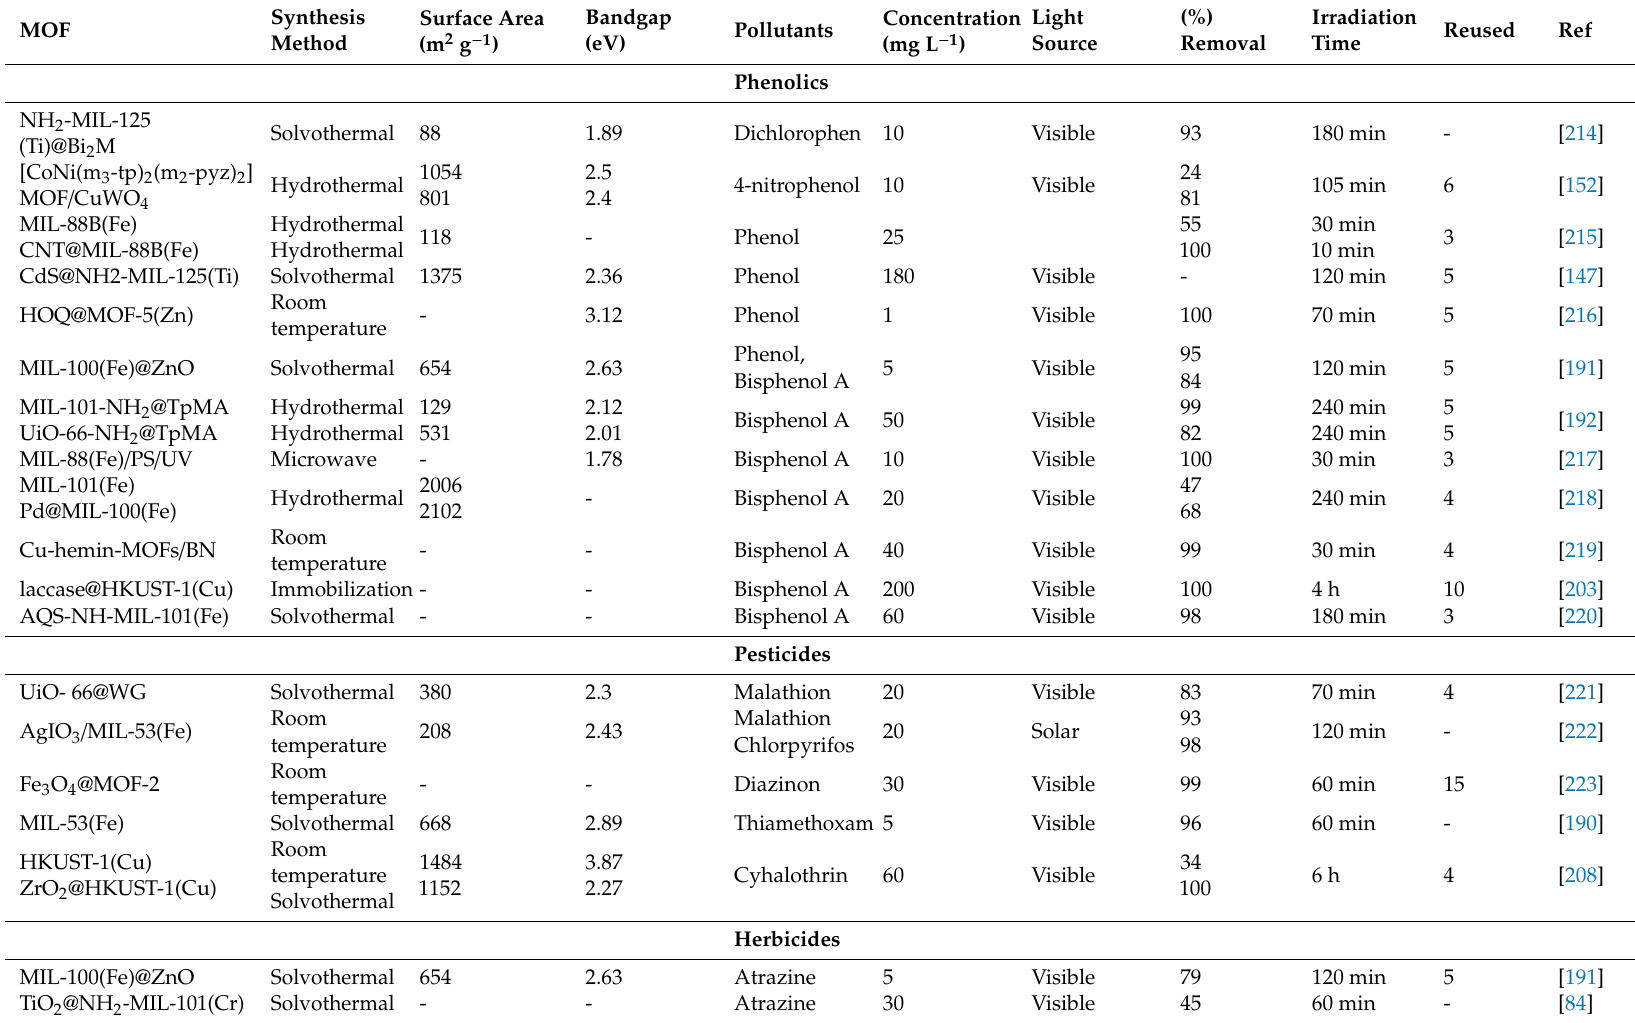
Table 4. MOFs and composites reported for the photocatalytic degradations of phenols, herbicides, pesticides, and other miscellaneous organic pollutants.